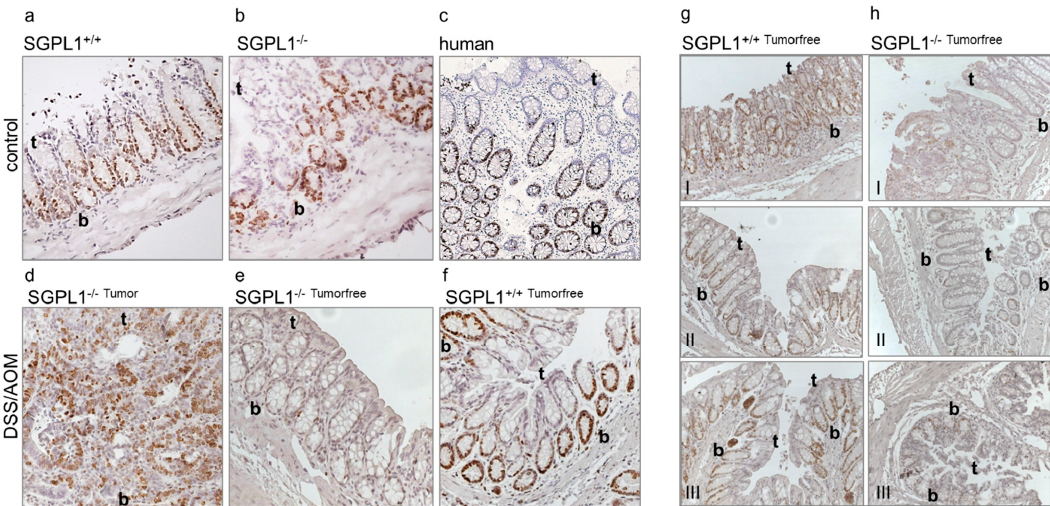
Figure 1. Anti-Ki-67 staining of ( a ) murine colon epithelium ( n = 5), ( b ) murine SGPL1 knockout colon epithelium ( n = 5), ( c ) human colon epithelium ( n = 4), ( d ) murine SGPL1 knockout colon tumor after CAC induction (9 weeks) ( n = 5), ( e ) murine SGPL1 KO colon epithelium ( n = 5), ( f ) murine colon epithelium after CAC induction (9 weeks) ( n = 5 (magnification 40 × ). Anti-Ki-67 staining ( n = 3) of ( g ) wildtype and ( h ) SGPL1 knockout colon sections in different locations (I distal colon, II mid colon, III proximal colon); (magnification 20 × ); CAC = colitis associated colon cancer; in image: t = Crypt tip; b = crypt bottom.